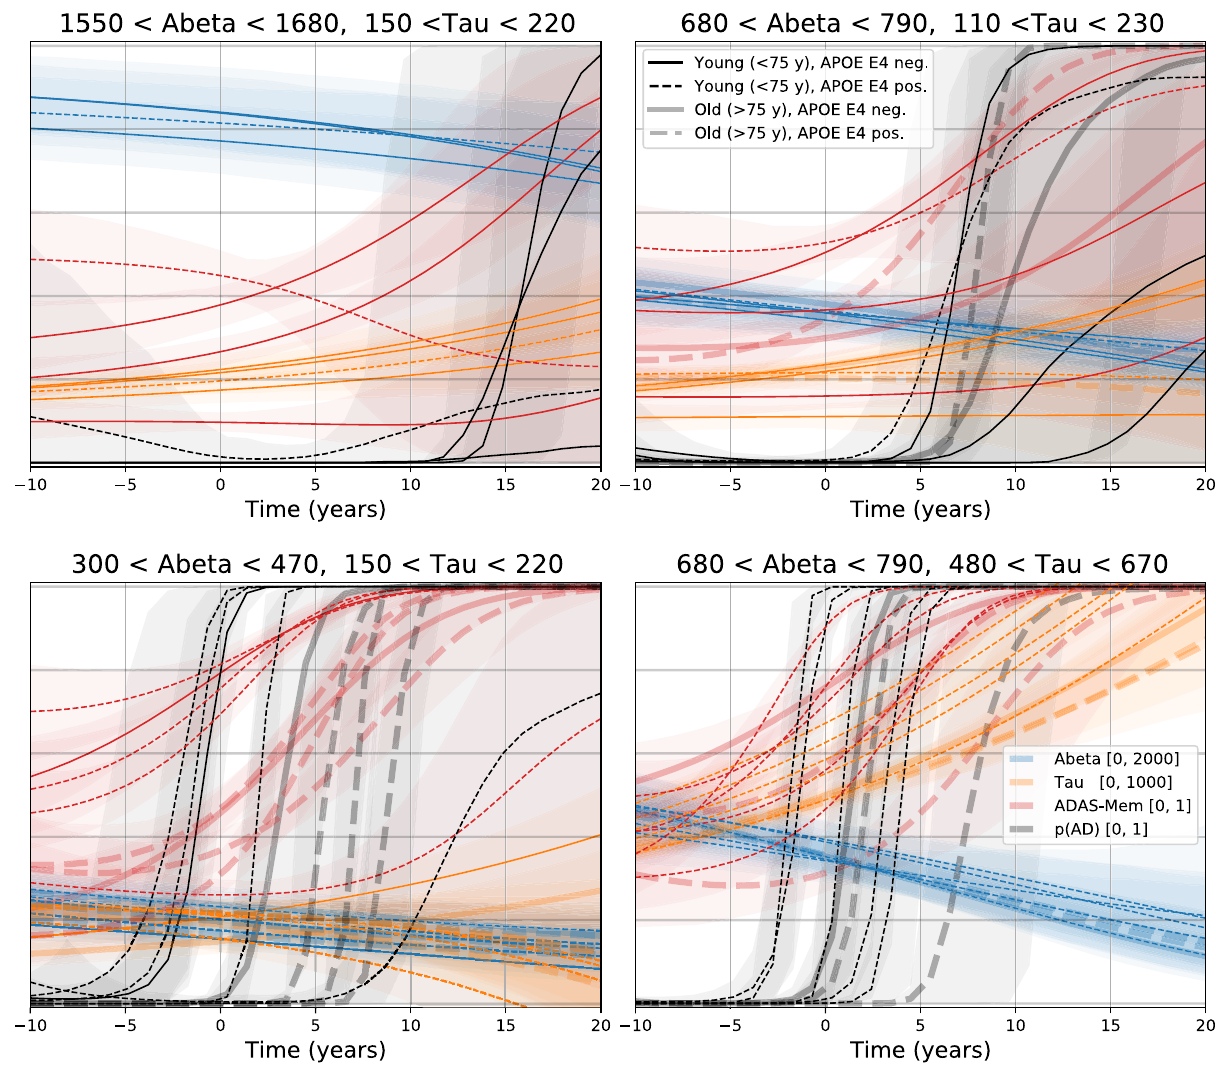
Figure 7. Simulated long-term evolution for different initial conditions. Subjects for whom the basal CSF biomarker levels were within limits described on top of each panel and with a smaller uncertainty were selected. Then, trajectories were propagated 10 years backwards and 20 years forwards, taking into account the subject’s parameters and the model uncertainty. The y-axis range for each biomarker is indicated in the legend at the bottom right